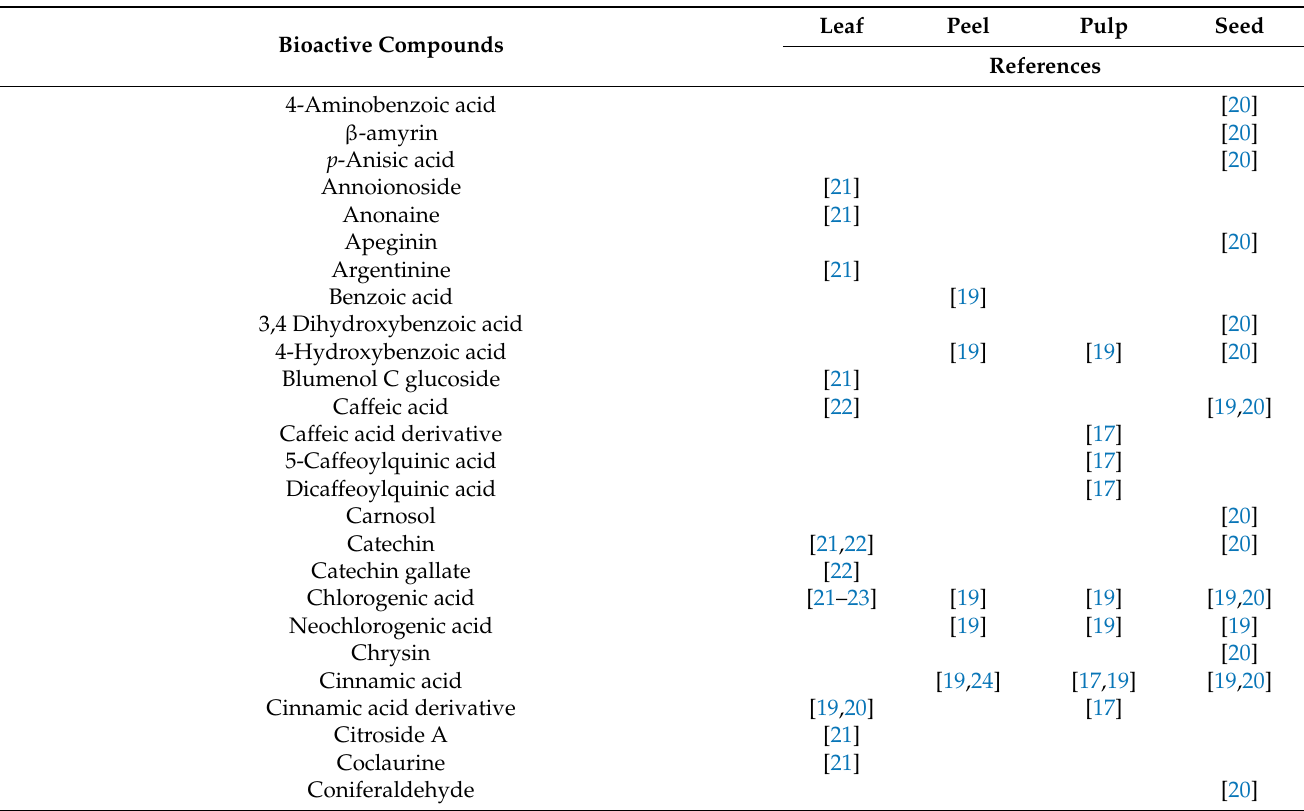
Table 1. Bioactive compounds in soursop leaf peel, pulp, and seed. Bioactive